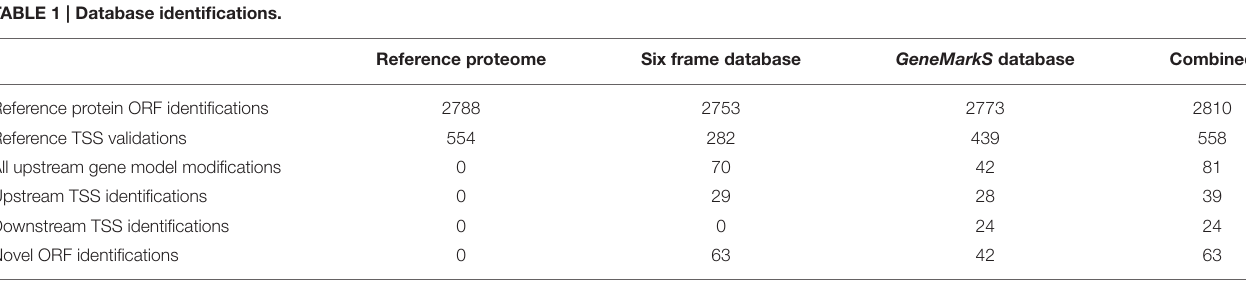
TABLE 1 | Database identifications.